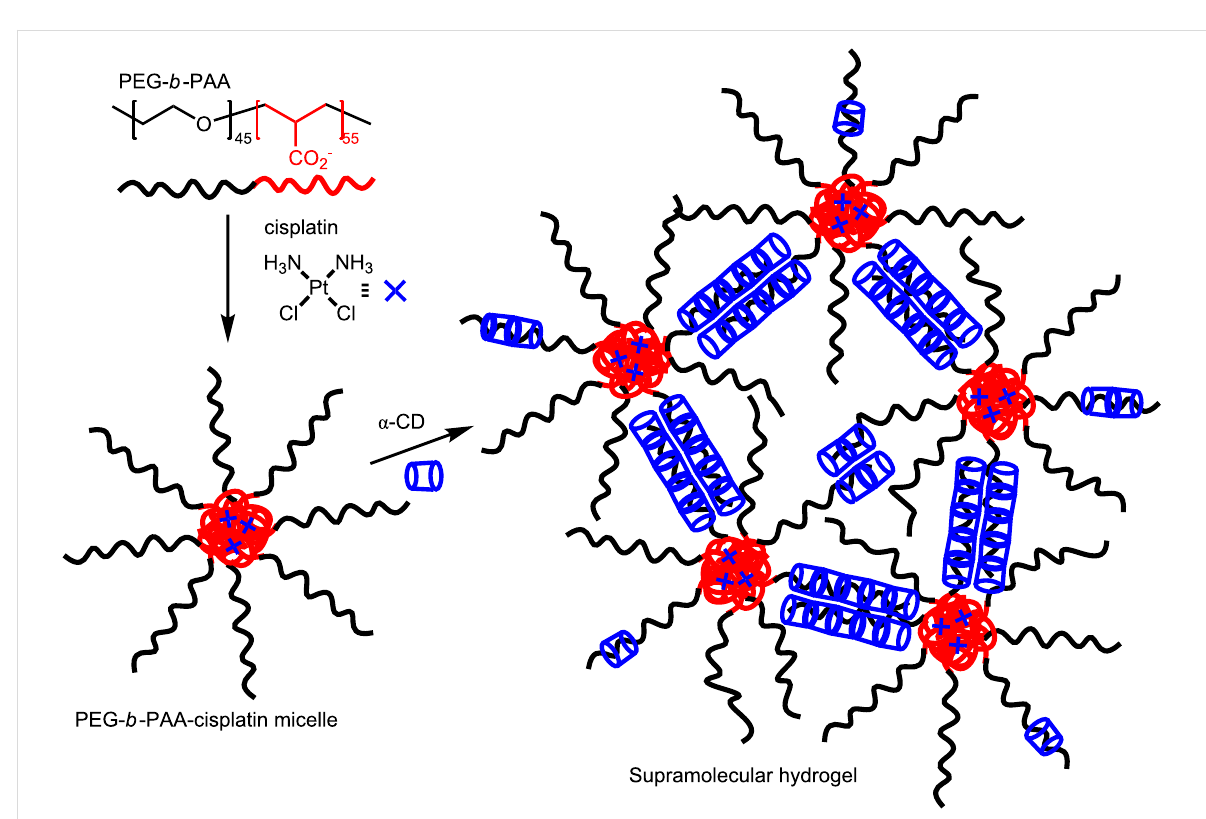
Figure 12: Interaction of PEG- b -PAA block copolymer with cis -diamminedichloroplatinum(II), cisplatin, to form a PEG- b -PAA-cisplatin micelle fol- lowed by the addition of α -CD to form a supramolecular hydrogel